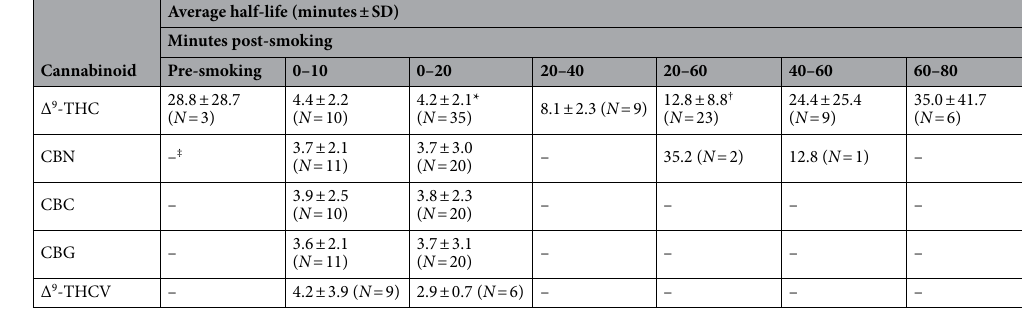
Table 3. Summary of cannabinoid half-lives in breath post-smoking. * p < 0.0001 compared to 60–80 min; † p = 0.0201 compared to 60–80 min (two-tailed t-test with Bonferroni’s adjustment for multiple comparisons; α = 0.025). ‡ Half-life not